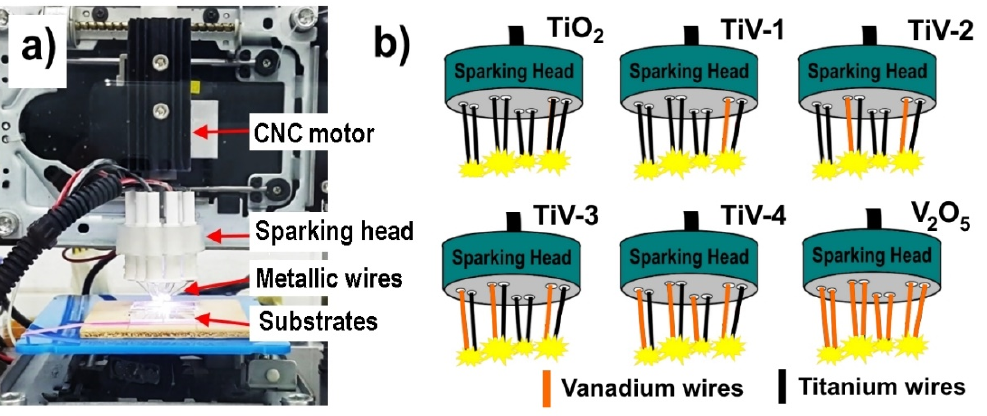
Figure 8. ( a ) Photo of the sparking apparatus and ( b ) schematic of sparking head of samples.